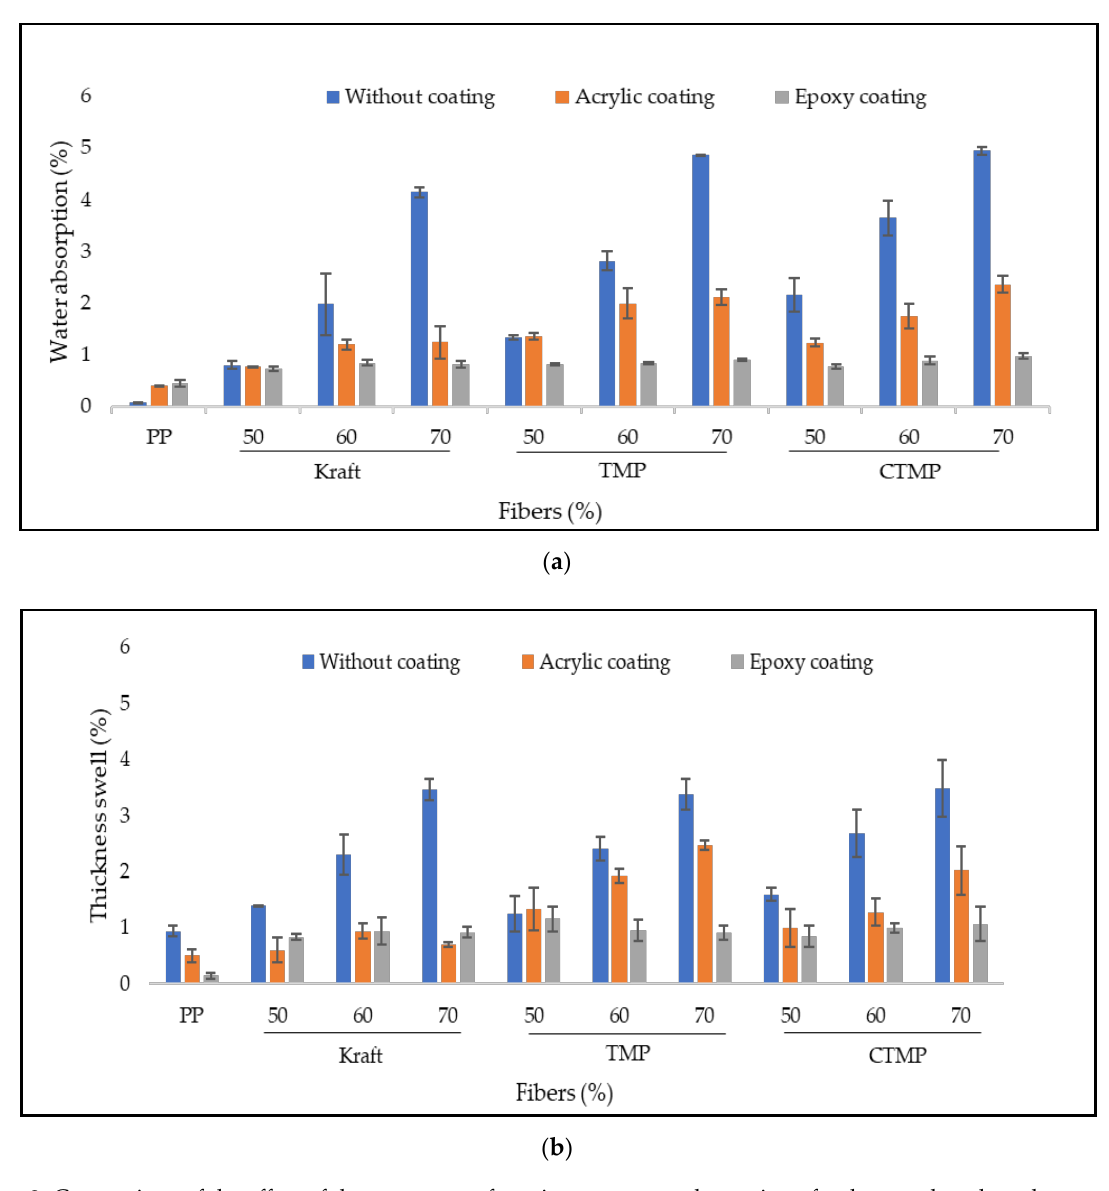
Figure 2. Comparison of the effect of the two types of coatings on water absorption of polypropylene-based composites: ( a ) Water absorption evolution and ( b ) thickness swell evolution.